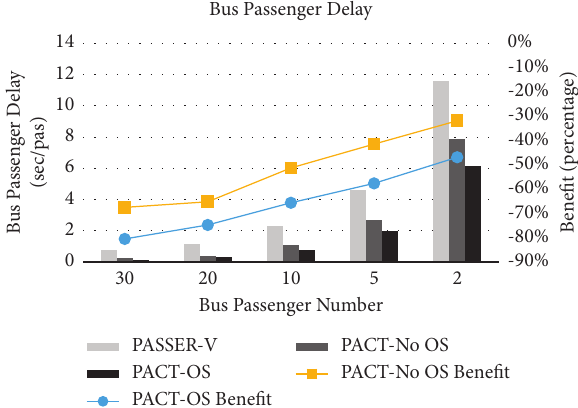
Figure 15: Delay changes in bus passenger under various bus occupancy.